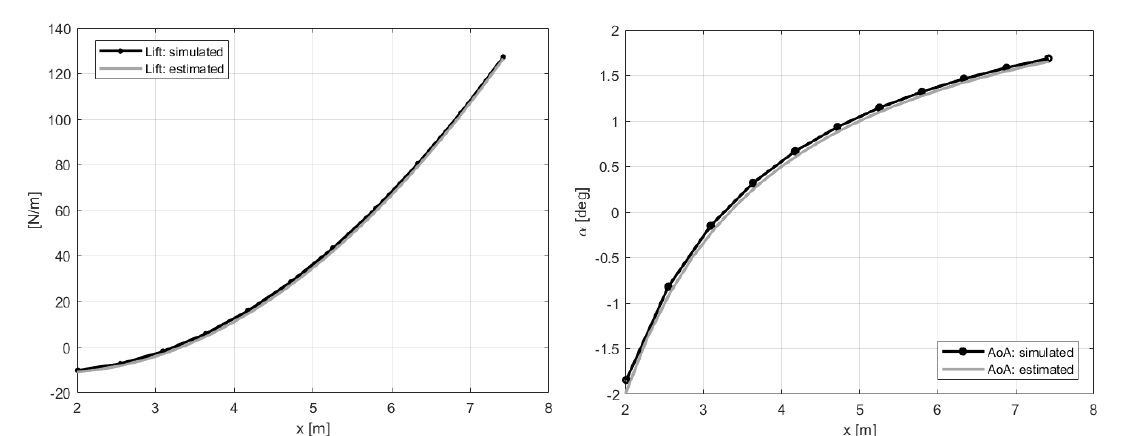
Figure 10. Distributed lift and angle of attack along the aerodynamic span in steady-state, with 11 points of integration. Reference noisy data used in the estimation.